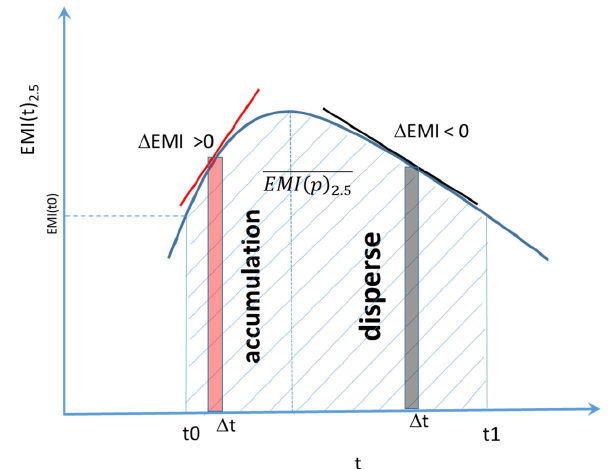
Figure 3. Relationship between the (cid:49) EMI, EMI( t ) 2 . 5 and EMI (p) 2 . 5